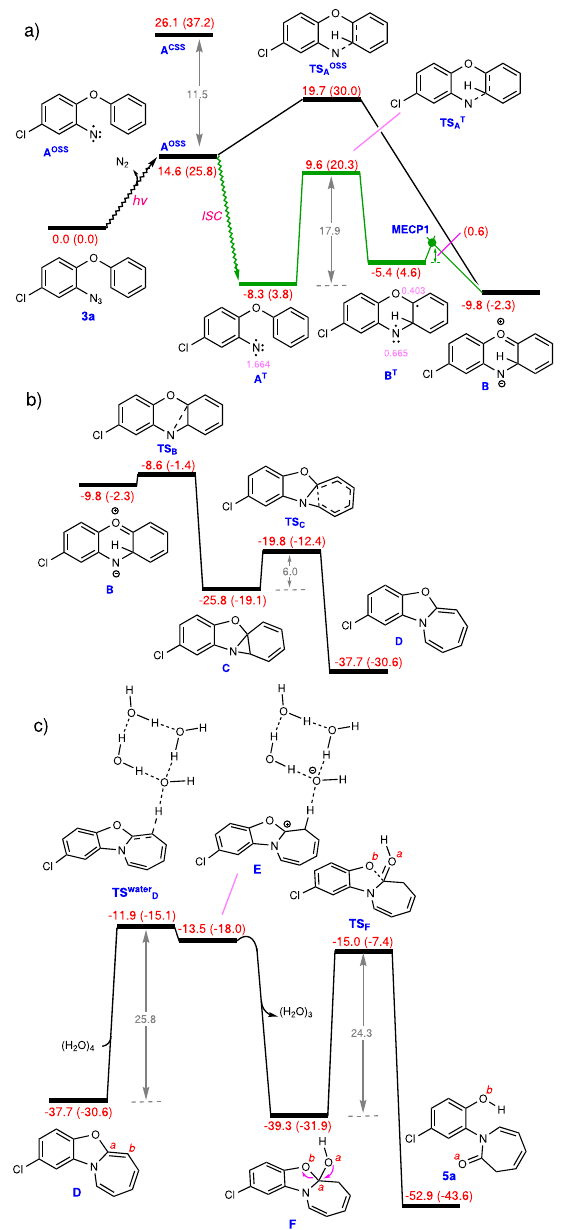
Fig. 7 | Calculated energy pro fi les. a The calculated energy pro fi le of the azir- idation step. b The calculated energy pro fi le of the aziridation step for the ring- closing and fi rst ring-opening steps. c The calculated energy pro fi le of the hydro- lysisandsecondring-openingsteps.Freeenergies(potentialenergies)calculatedat the SMD/M06-2X/def2-TZVP//SMD/M06-2X/6-31G(d) level of theory in THF are given in kcal/mol. The triplet pathway is shown in green. The pink values are the Mulliken spin density on selective atoms in A T and B T .